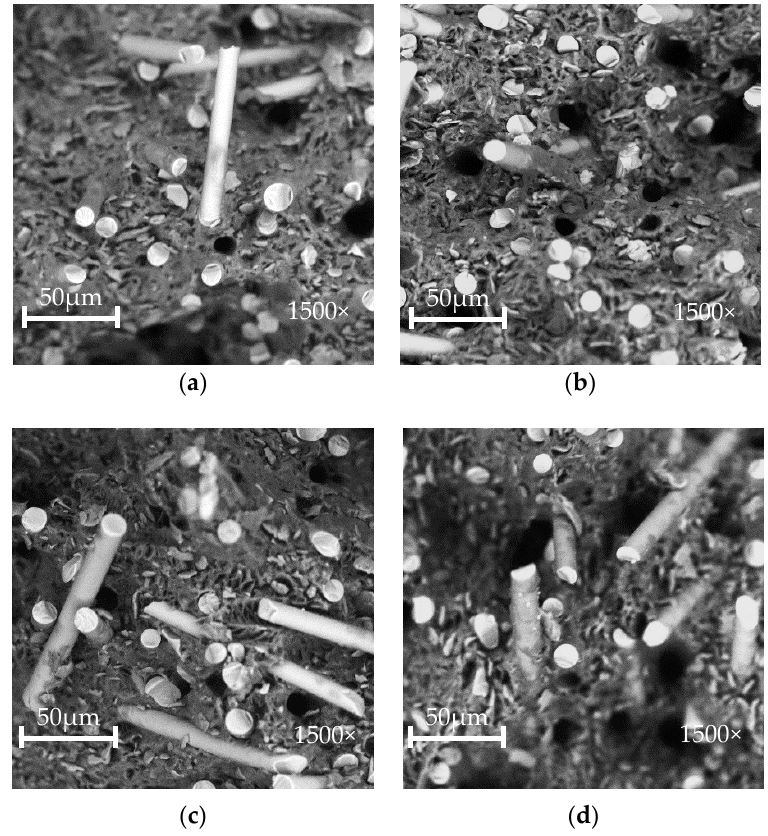
Figure 2. SEM micrographs of fractured surfaces for POM composites with ( a ) 4.0% PTFE etched for 10 min; ( b ) 17.3% PTFE etched for 10 min; ( c ) 9.5% PTFE etched for 2.9 min; ( d ) 9.5% PTFE etched for